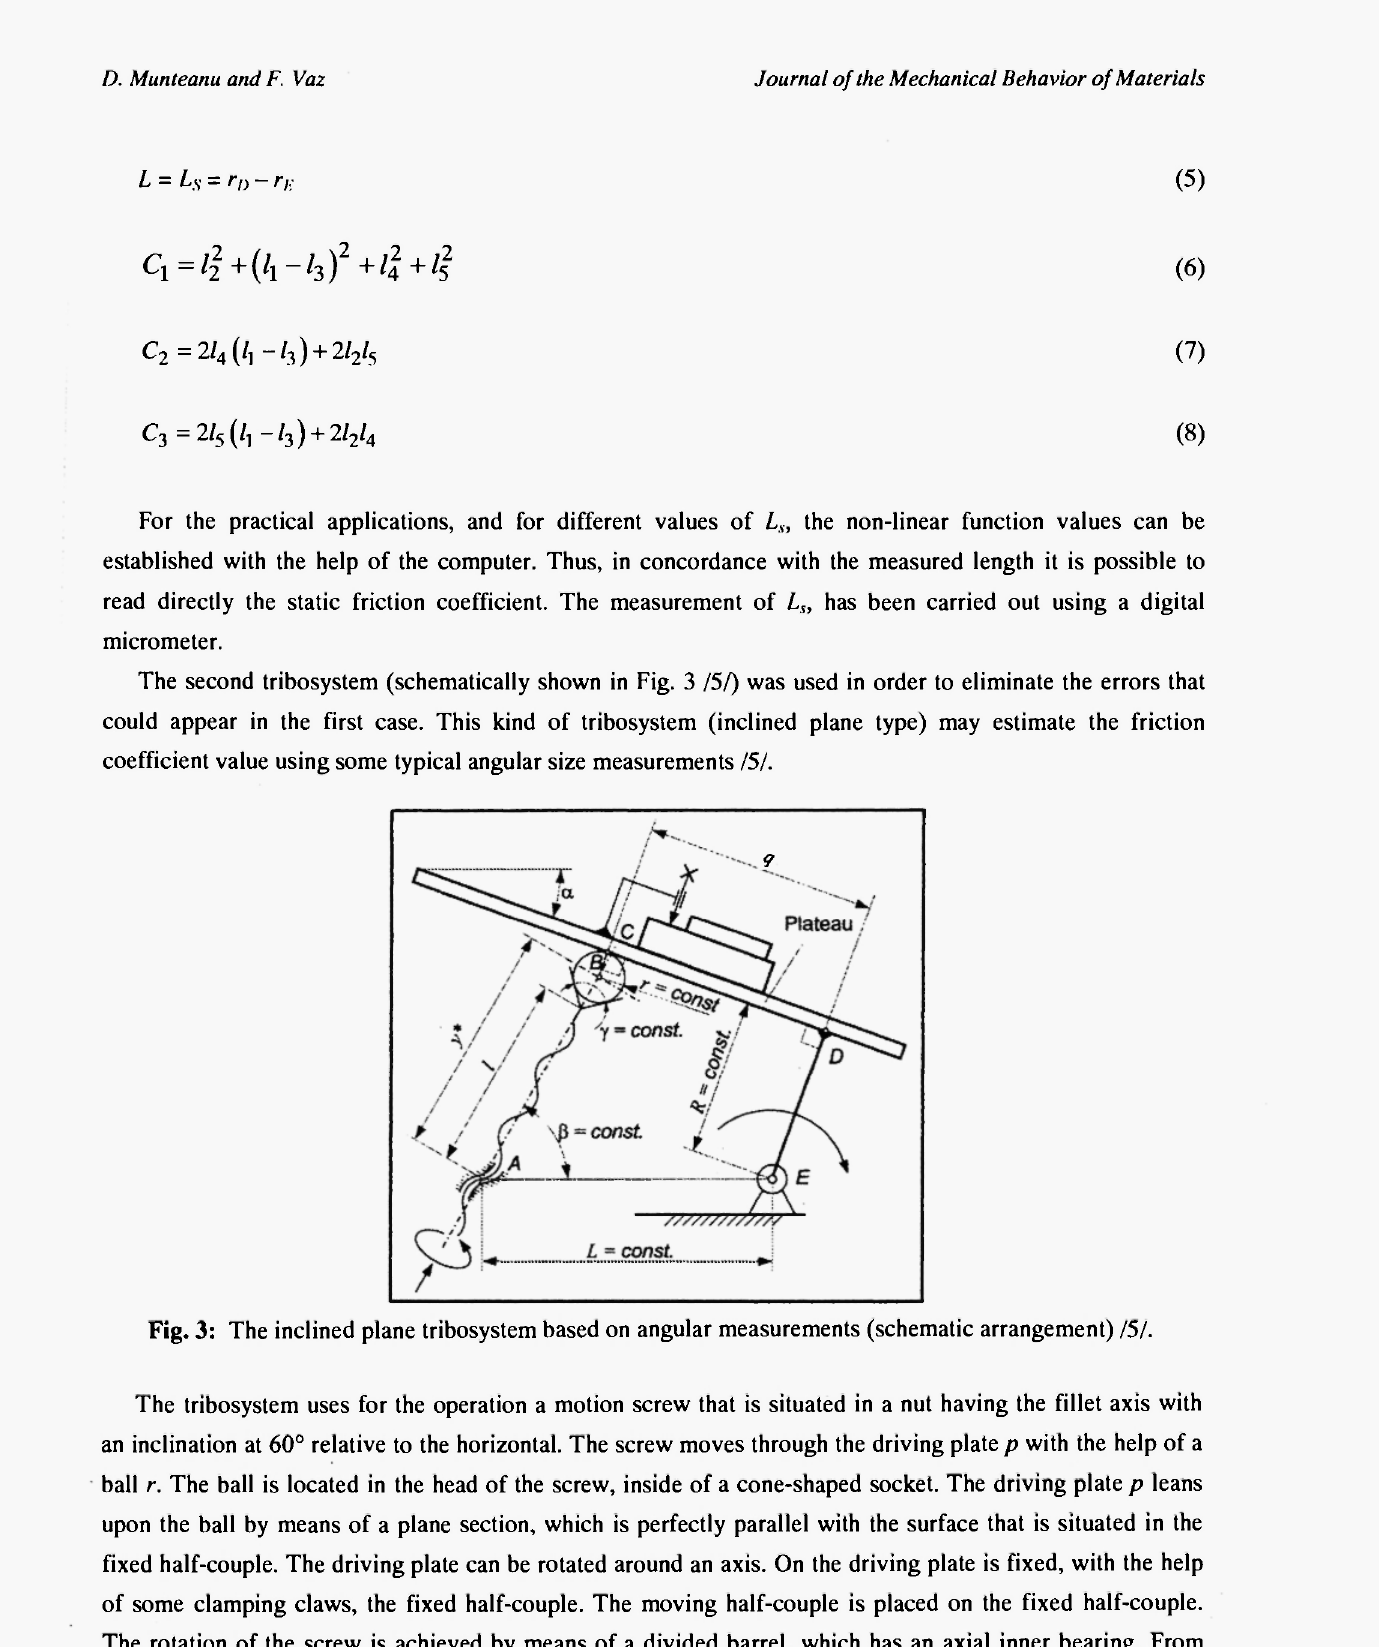
The tribosystem uses for the operation a motion screw that is situated in a nut having the fillet axis with an inclination at 60° relative to the horizontal. The screw moves through the driving plate ρ with the help of a ball r. The ball is located in the head of the screw, inside of a cone-shaped socket. The driving plate ρ